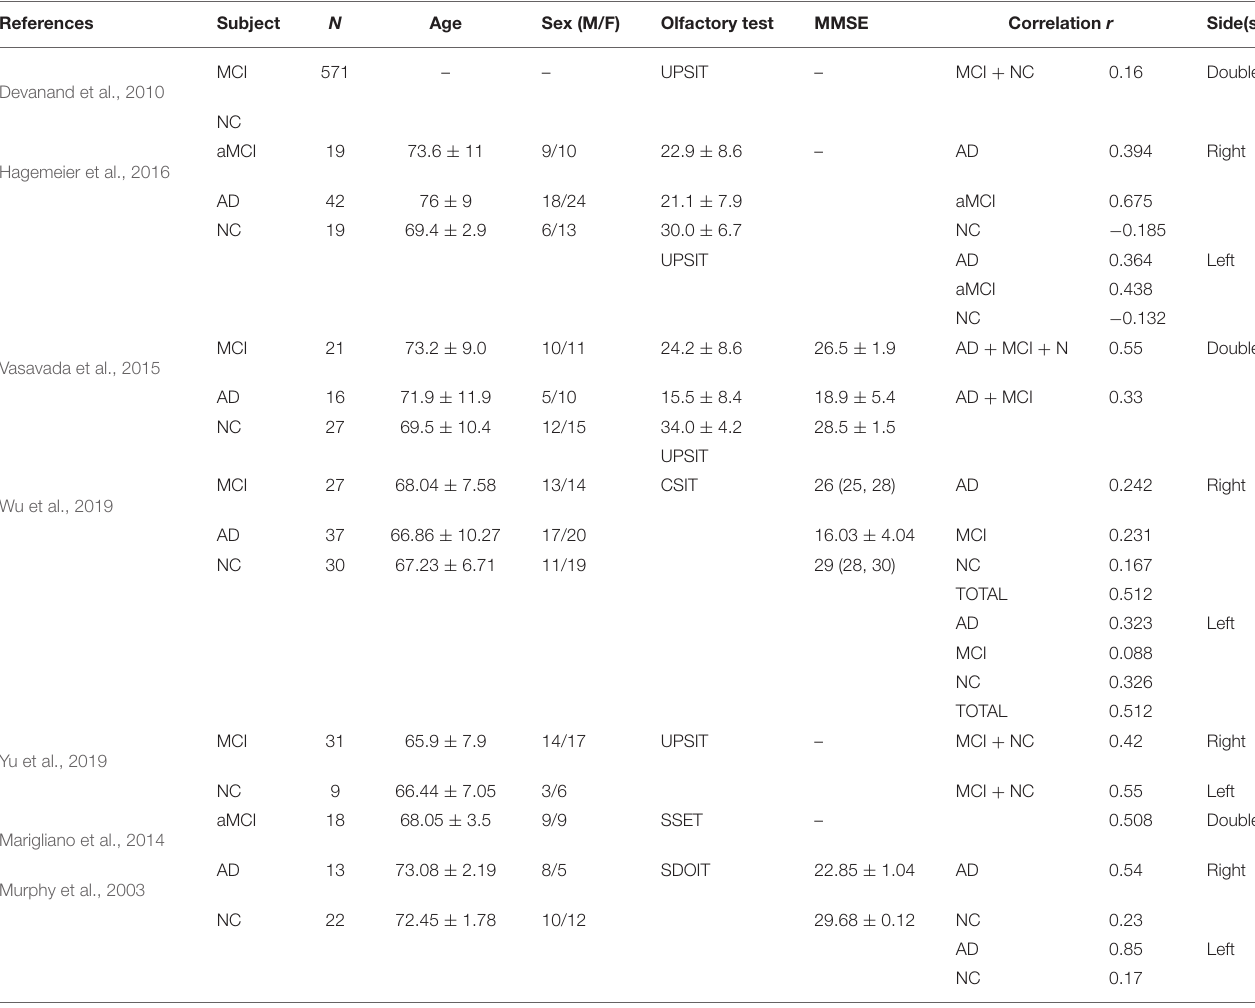
TABLE 1 | Demographic data and relevant